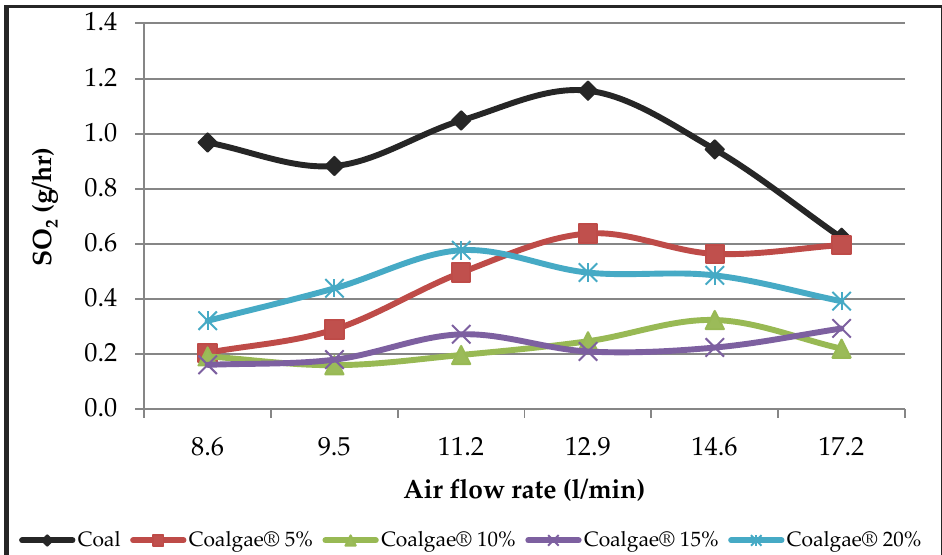
Figure 9. Effect of air flow rate on SO 2 emissions.